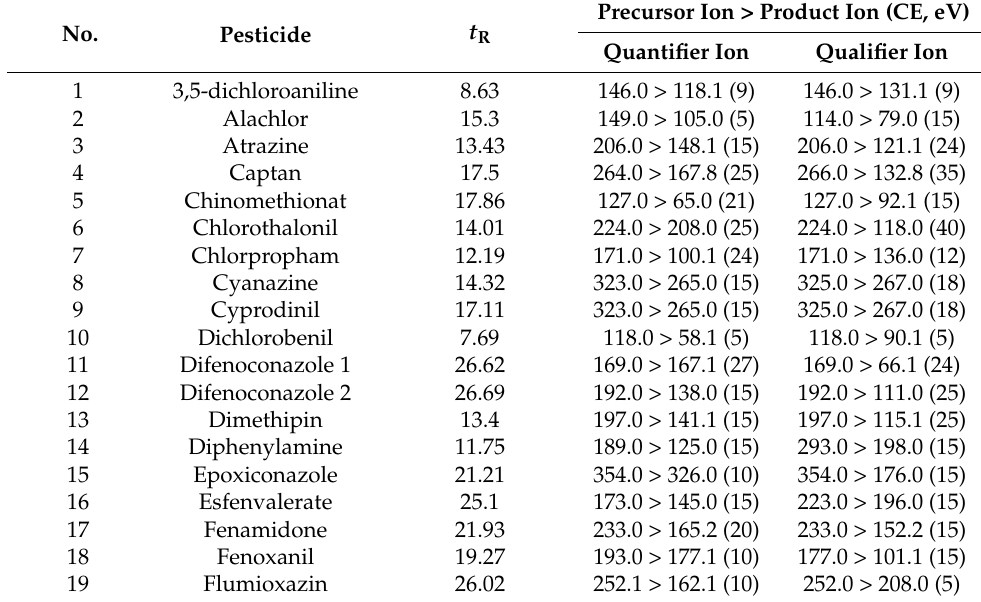
Table A1. GC-MS/MS parameters and retention time optimized for the determination of 32 com-